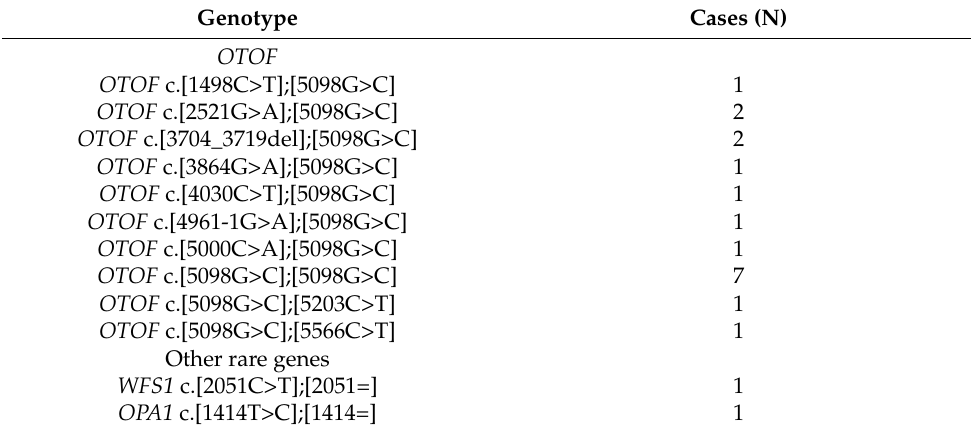
Table 1. Subjects with confirmed genotype in this study.